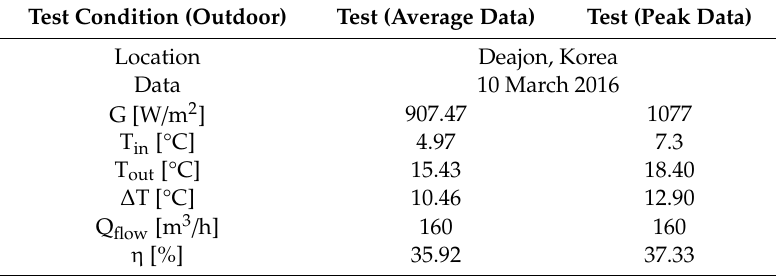
Table 3. Experiment data.